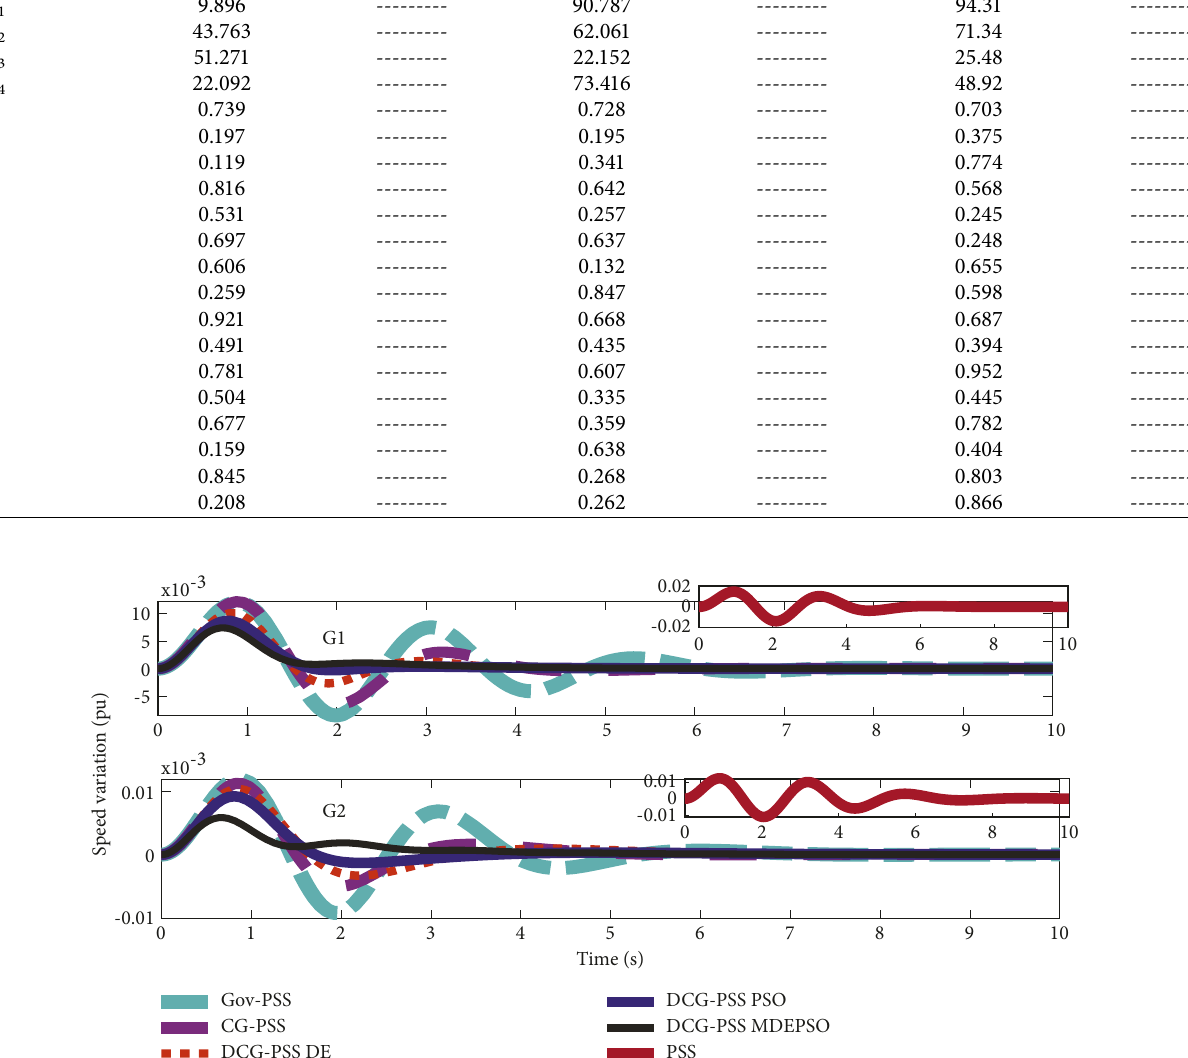
Figure 12: Angular frequency variation for G